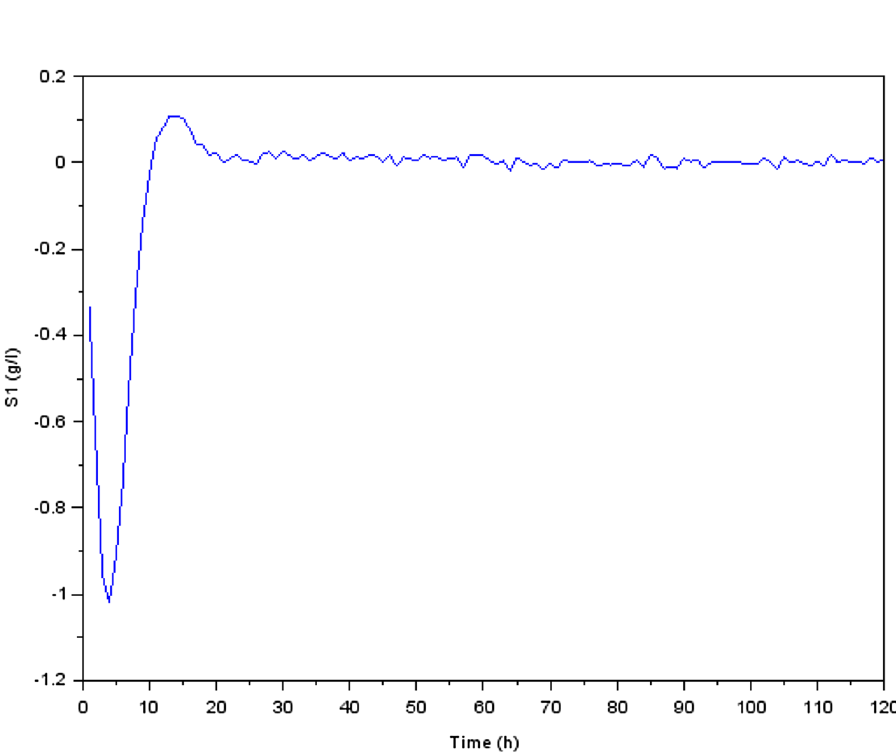
Figure 7. Variation of glucose concentration S 1